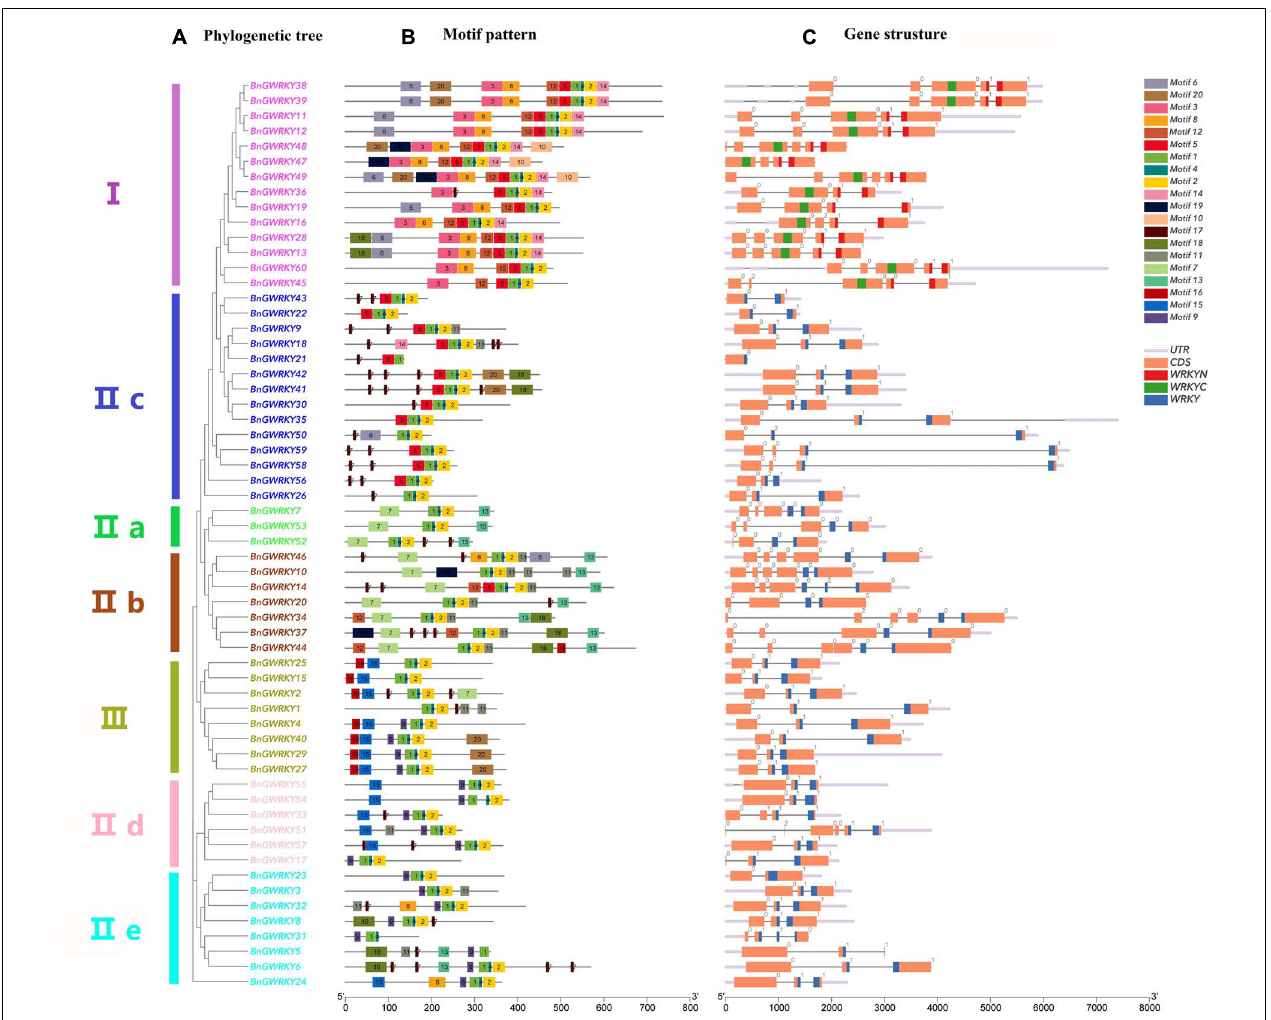
FIGURE 3 | Phylogenetic relationships, conserved motifs and gene structure of WRKY genes from ramie. (A) The neighbor-joining tree based on the full-length protein sequences of 60 Boehmeria nivea WRKYs with 1,000 bootstrap replicates. (B) The motif composition of ramie WRKY proteins. The sequence information for each motif is provided in Supplementary Table 2 . (C) The intron–exon structures of BnGWRKY genes. The WRKY domains are highlighted by blue/red/green boxes. The number indicates the phases of corresponding